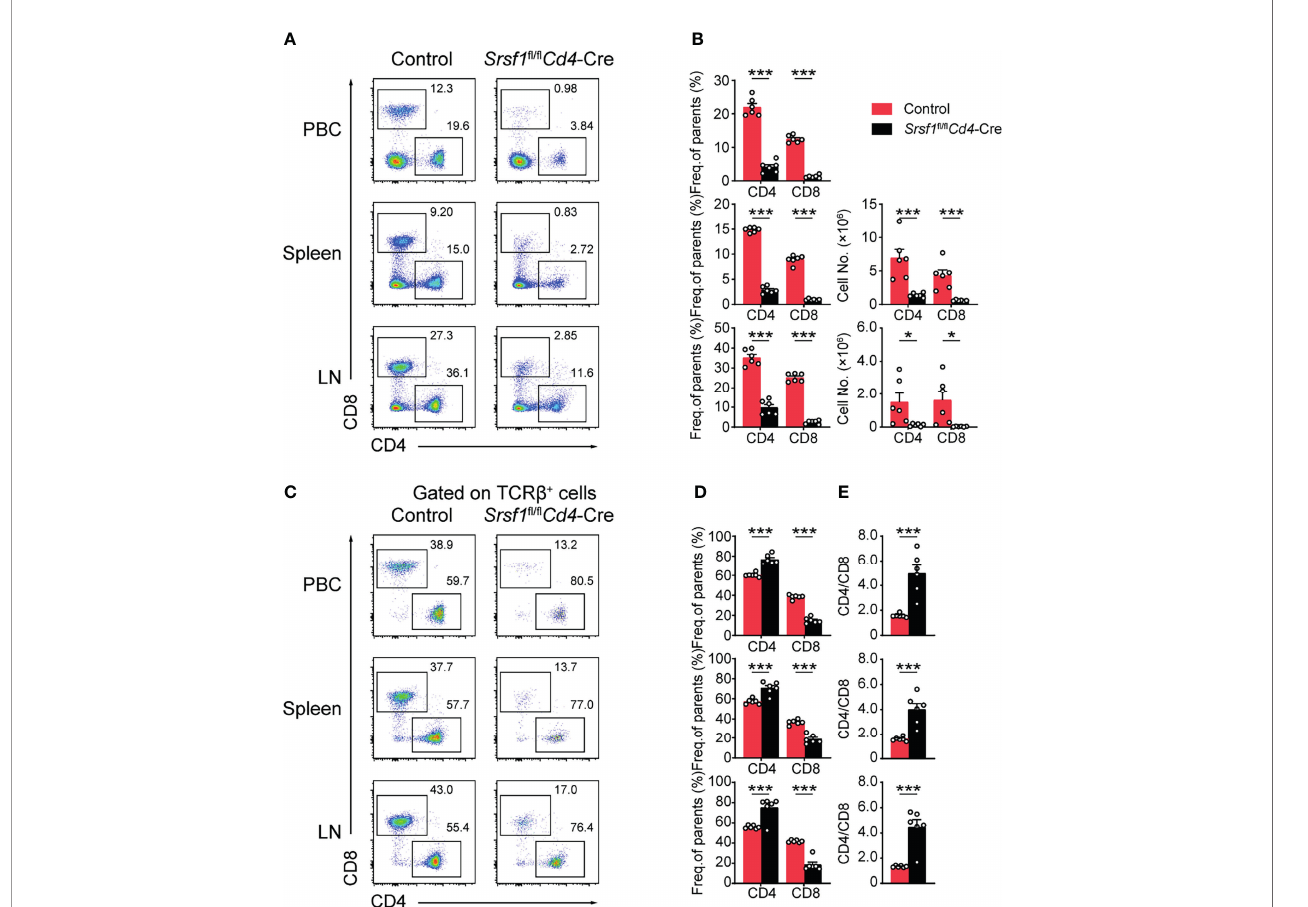
FIGURE 3 | The proportion of peripheral CD4 + to CD8 + T cells was disturbed in Srsf1 fl / fl Cd4 -Cre mice. (A, B) Flow cytometry analysis of T cells in peripheral tissues. (A) Representative pseudocolor plots show CD4 + and CD8 + T cells in PBC, spleen, and LNs from Control and Srsf1 fl / fl Cd4 -Cre mice. The frequency and numbers of indicated subsets in spleen, and LNs were shown in (B) , accordingly ( n = 6). (C – E) Analysis of the ratio of frequency between peripheral CD4 + T cells and CD8 + T cells. (C) Representative pseudocolor plots show CD4 + and CD8 + T cells from TCR b + populations in PBCs, spleen, and LNs. The frequency and numbers of indicated subsets were shown in (D) ( n = 6), and the ratio of frequency between CD4 + T cells to CD8 + T cells was calculated and shown in (E) , respectively. Data were collected from at least three independent experiments. The error bars are means ± SD. Statistical signi fi cance was determined by one- tailed Student ’ s t -test. *P < 0.05 and ***P < 0.001